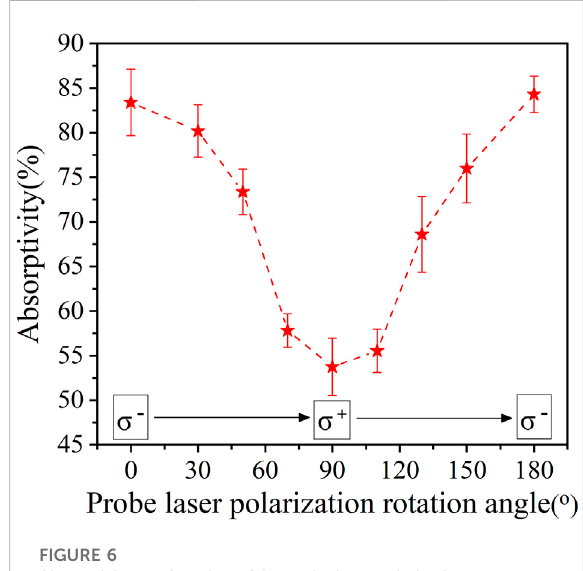
FIGURE 5 (A) Dependence of the peak transmission on pump laser power.Theprobelaserpoweriskeptat3 μ W.Theupperrightinset is an image of cold atomic cloud observed when the external incident laser power is high. (B) Dependence of the transmitted signal and peak transmission on probe laser power. The pump laser power is kept at 1 mW, and the green curve is the fi tting curve of the green points.